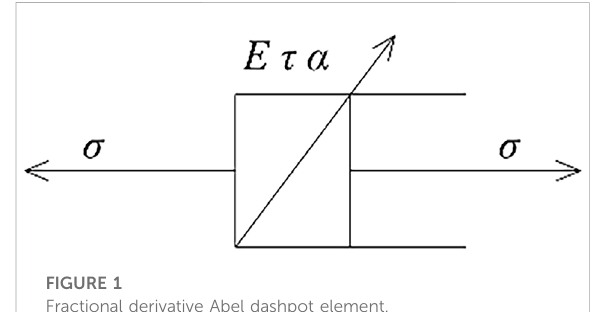
TABLE 1 Technical index of matrix asphalt.